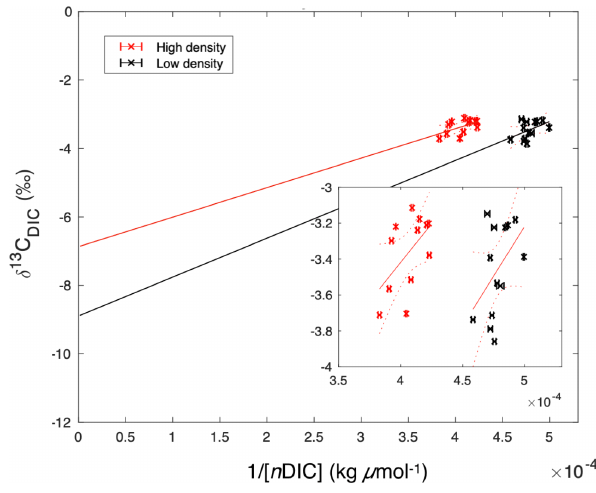
Figure 10. Keeling plot of 1 / [ n DIC ] versus δ 13 C DIC , suggesting potential endmember isotopic values. These y intercept δ 13 C DIC values were − 6 . 9 ± 3 . 7 and − 8 . 8 ± 6 . 8‰ (95% confidence interval) for the high- and low-density sites, respectively. The inset figure is zoomed to the extent of collected data, while the large figure is scaled to demonstrate the extrapolation required in order to extend the data to the y